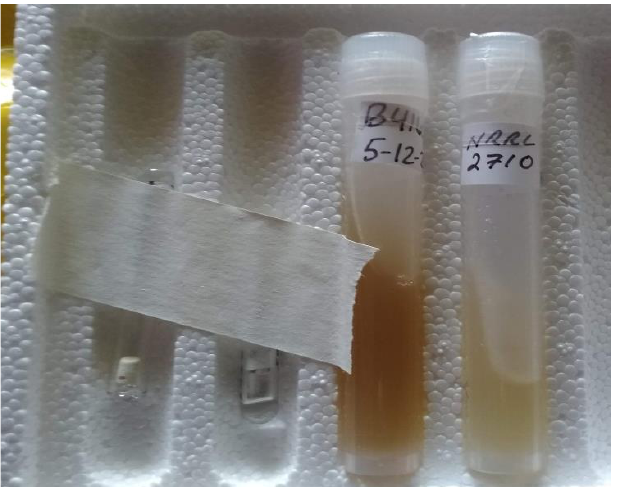
Figure 1. Microbial culture from USDA (Rhizopus oligosporus and Lactobacillus plantarum).